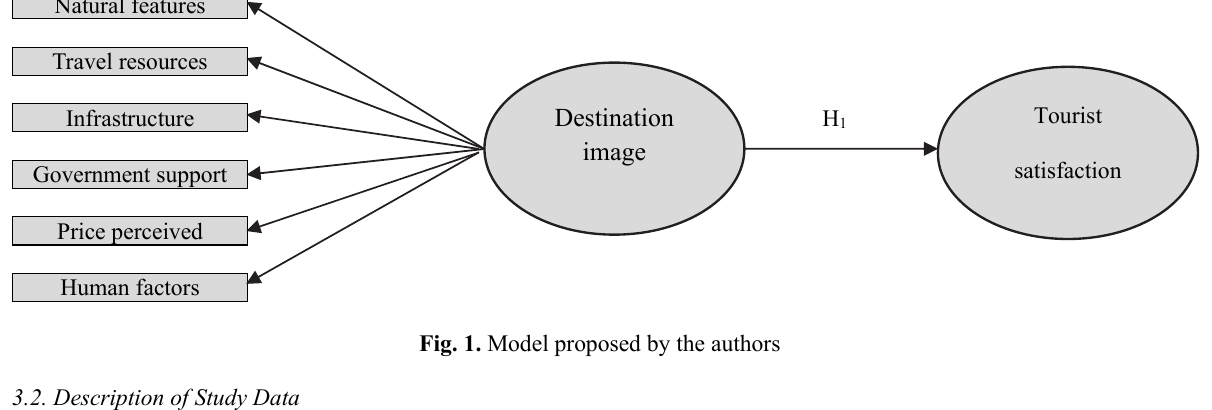
Fig. 1. Model proposed by the